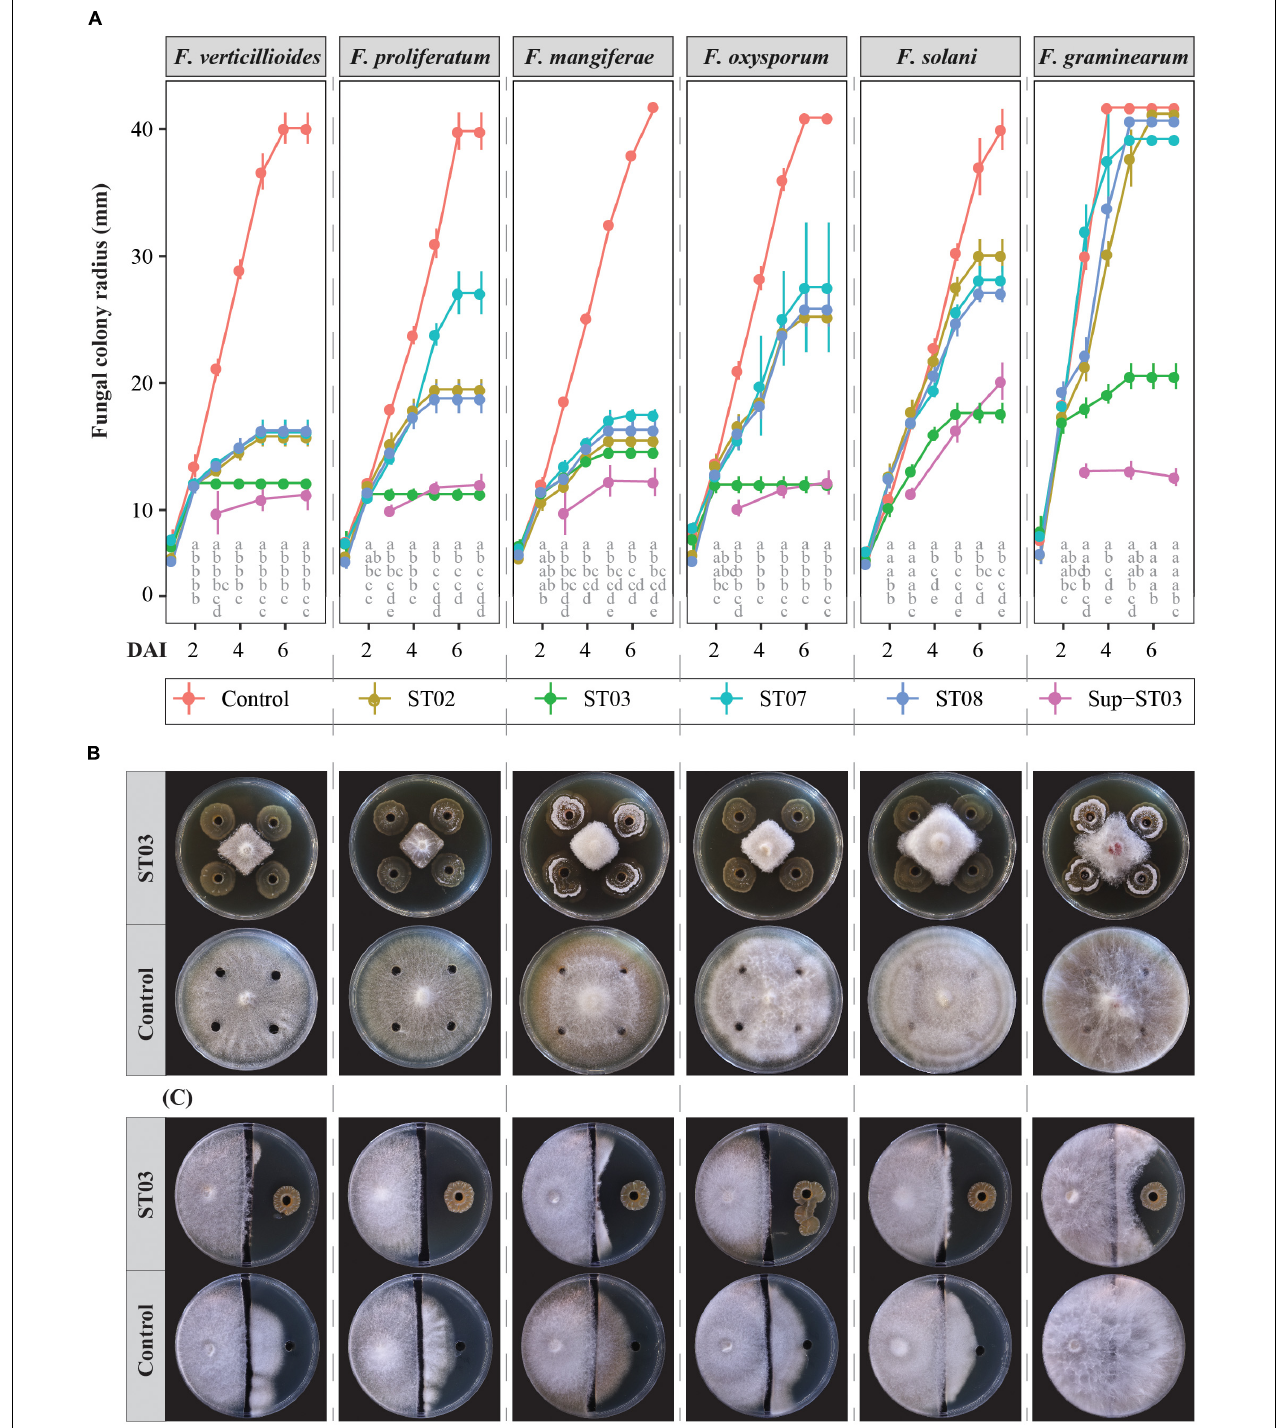
FIGURE 1 | In vitro antagonism of four Streptomyces strains (ST02, ST03, ST07, and ST08) against six Fusarium species. (A) Fungal colony radii (mm) by days of inoculation (dai) between 1 and 7 dai. Four cell suspensions of ST02, ST03, ST07, and ST08, respectively, and one 10-time-concentrated supernatant of the strain ST03 (Sup-ST03) were used. Water or tryptic soy broth were used as the mock controls. Different letters by columns pinpoint a significant difference between treatments at each time point using an ANOVA test and a post hoc Turkey test at α = 0.05. (B) An in vitro diffusion assay of the ST03 cell suspension at 7 dai against 6 Fusarium species as (A) . (C) An in vitro volatile assay of the strain ST03 at 11 dai. Four biological replicates were done per treatment. The experiment was repeated twice.